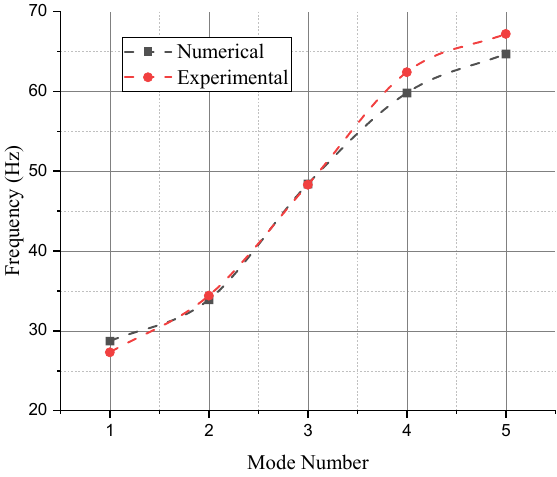
Figure 25. Numerical validation of model analysis.